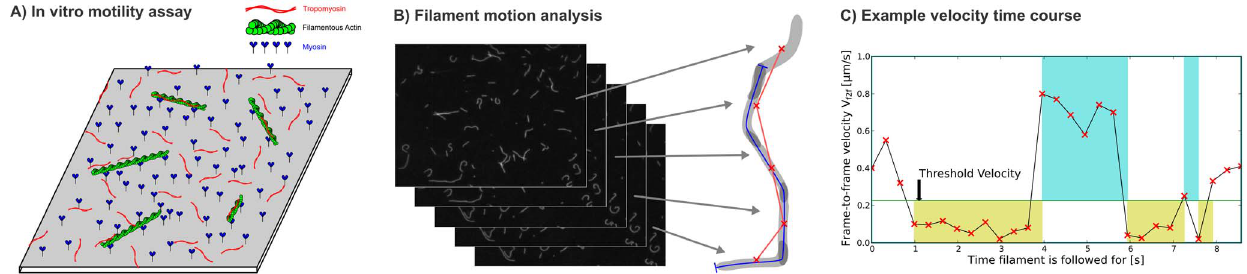
Figure 1. Invitro motility assay and video analysis. A) Purified smooth muscle myosin motors are immobilized on a microscope cover slip and propel fluorescent actin filaments in the presence of ATP. For conditions whose protein combinations contained tropomyosin (Tab. 1), tropomyosin was added into the assay buffer in excess of actin. B) Filament images are extracted from and tracked across consecutive video frames. The filament trace velocity ( V ) is determined from the trace resulting from the whole tracking of a filament (blue line). The frame-to-frame velocities ( V f 2 f ) are determined from the centroid displacements between every two consecutive frames (centroids – red crosses, displacements – red lines). C) The motile fraction ( f mot ), stop times ( t stop – beige regions), and run times ( t run – light blue regions) are determined from V f 2 f time courses.